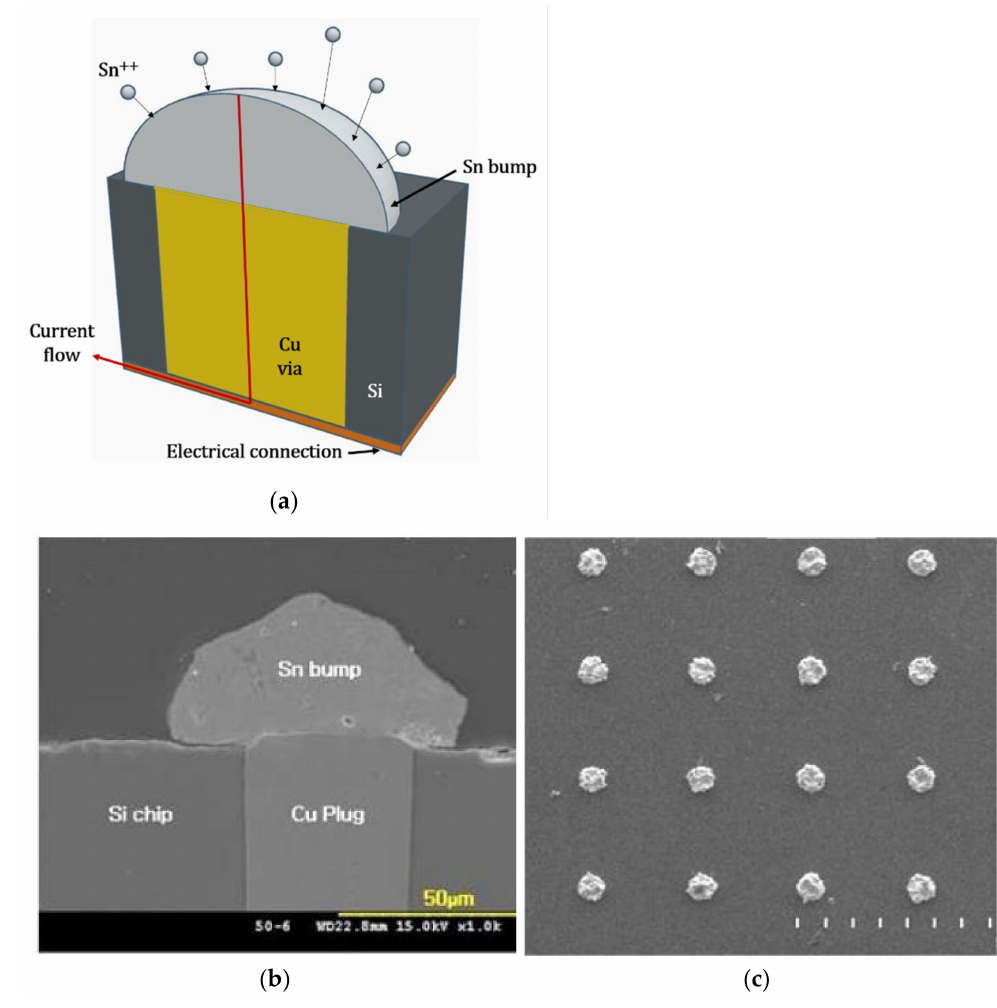
Figure 16. ( a ) Schematic illustration of the metal layer on the Si wafer for the electrical connection of solder bump; ( b ) cross-section of a bump; ( c ) top view of bumps array